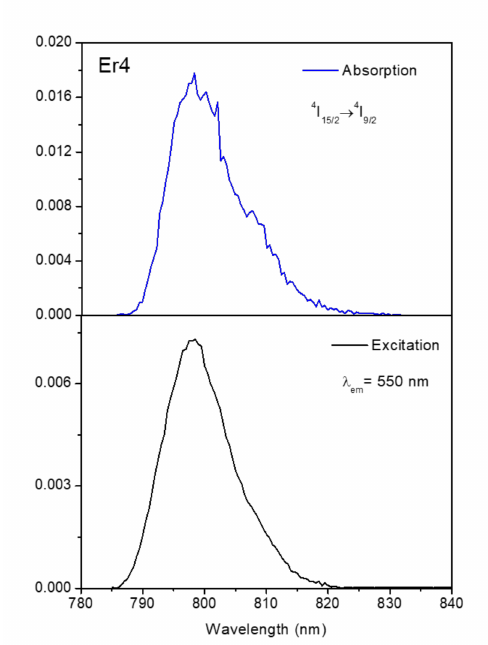
Figure 9. Excitation spectra of upconverted green emission from the 4 S 3/2 level and square of the one photon absorption spectra of the aluminosilicate glass doped with 4 wt% Er 2 O 3